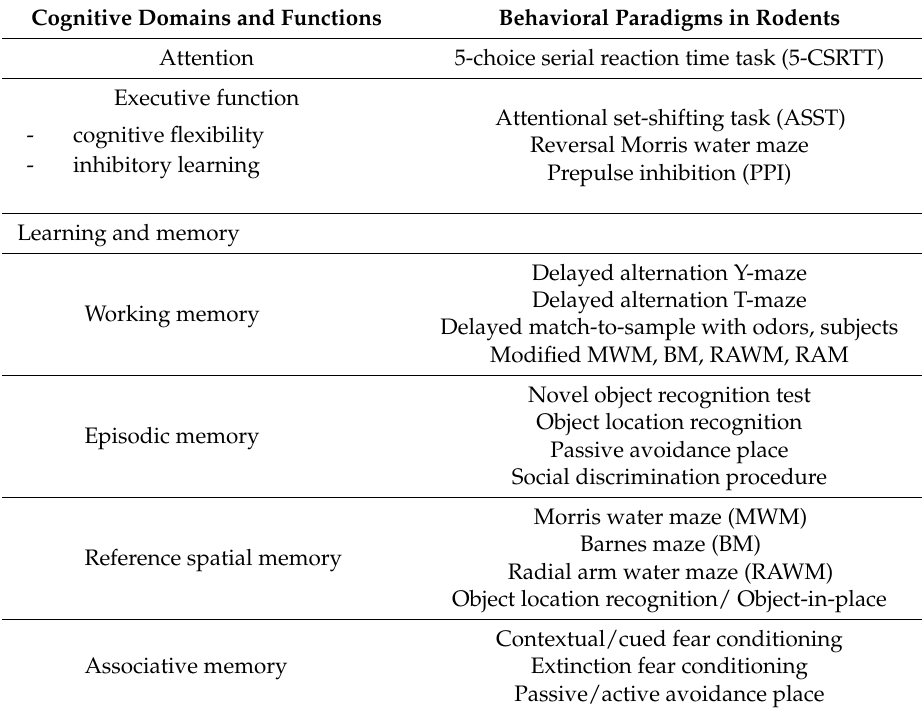
Table 2. Behavioral paradigms in rodents used to assess cognitive functions in anxiety/depression